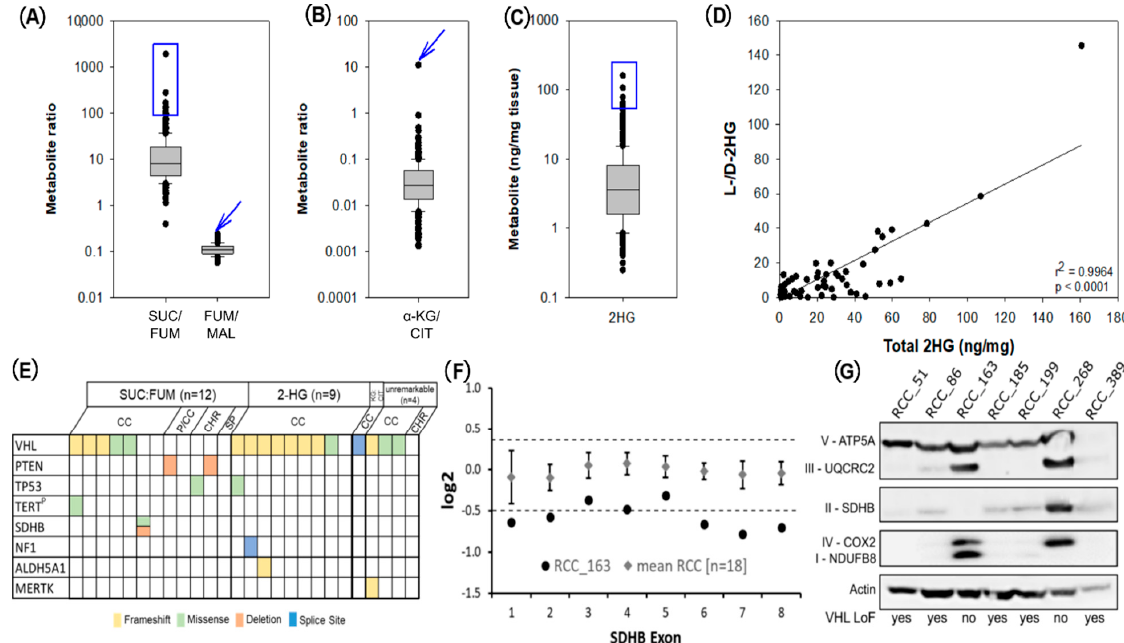
Figure 5. Screening for metabolic outliers with potentially underlying mutations using LC-MS/MS measurements of Krebs cycle metabolites. ( A ) Succinate:fumarate (SUC/FUM) and fumarate:malate (FUM/MAL) ratios; 12 tumours with the highest succinate:fumarate ratios and the tumour with the highest fumarate:malate ratios were sequenced (blue box and arrow, Supplementary Table S1). ( B ) α -ketoglutarate:citrate ( α -KG/CIT) values (blue arrow, Supplementary Table S1). ( C ) Total 2-hydroxyglutarate (2HG) values; 10 tumours with the highest values were sequenced (blue box, see Supplementary